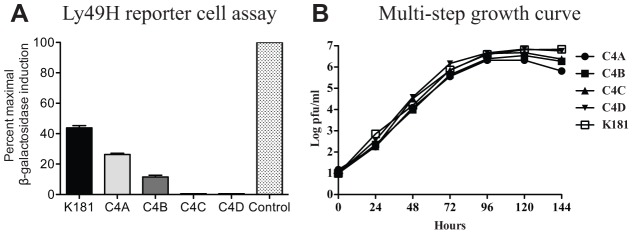
Within-host dominance mirrors the capacity of MCMV strains to ligate Ly49H.
A. Ly49H reporter cell assay. MEF were infected with K181 (positive control) or the C4 strains of MCMV and used to stimulate the Ly49H reporter cell line BWZ-HD12. The percent maximal β-galactosidase production was quantified relative to the PMA/ionomycin control (stippled bar). Both C4A and C4B stimulated β-galactosidase production by reporter cells, whereas C4C and C4D infected cells failed to stimulate β-galactosidase expression. B. Multi-step growth curves for the C4 strains of MCMV. MEF were infected with an MOI of 0.01 and replication rates assessed by plaque assay over a six day period. All viral strains replicated to similar levels in MEF.